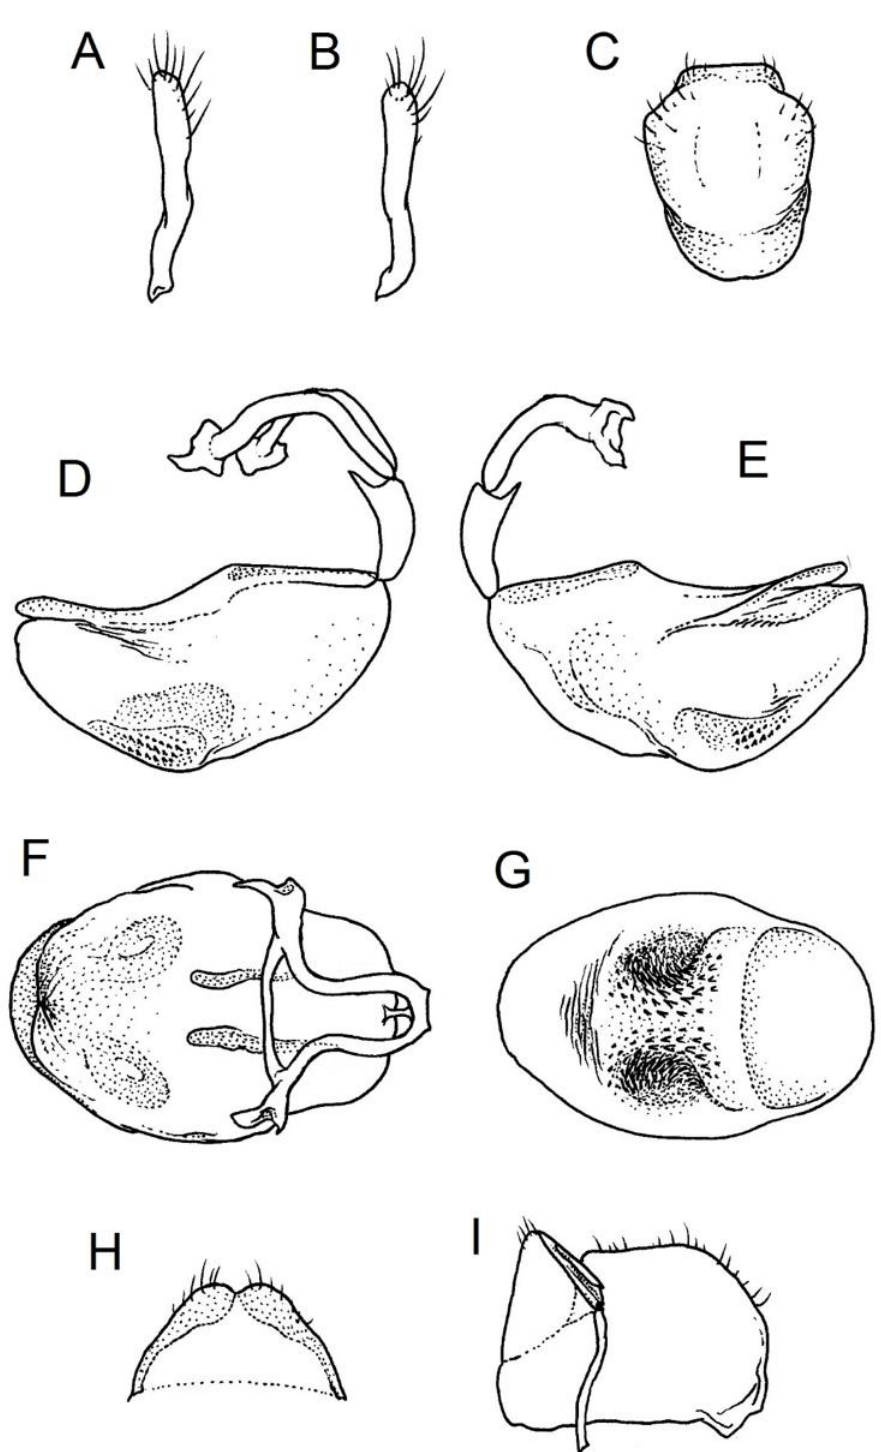
10. Phonoctonus nigrofasciatus Stål, 1855 (Figures 4D, 5D, 6J, 8J, 15B, 16L, 24C, 25C, 26M,N, 30C,D, 46B and 51) stat. rev.